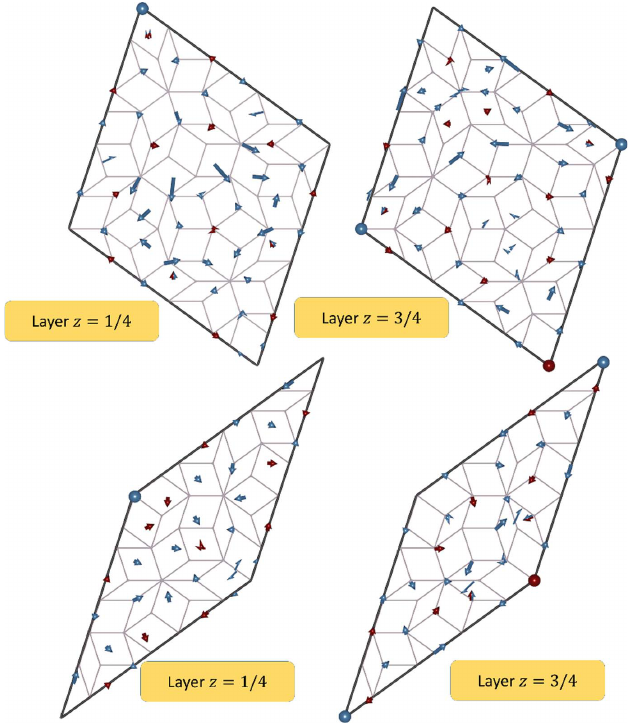
Figure 12 Vector and magnitude of the atomic shift after the refinement from the initial position. The colors of the arrows refer to the atomic species (following the same scheme as in Fig. 2).